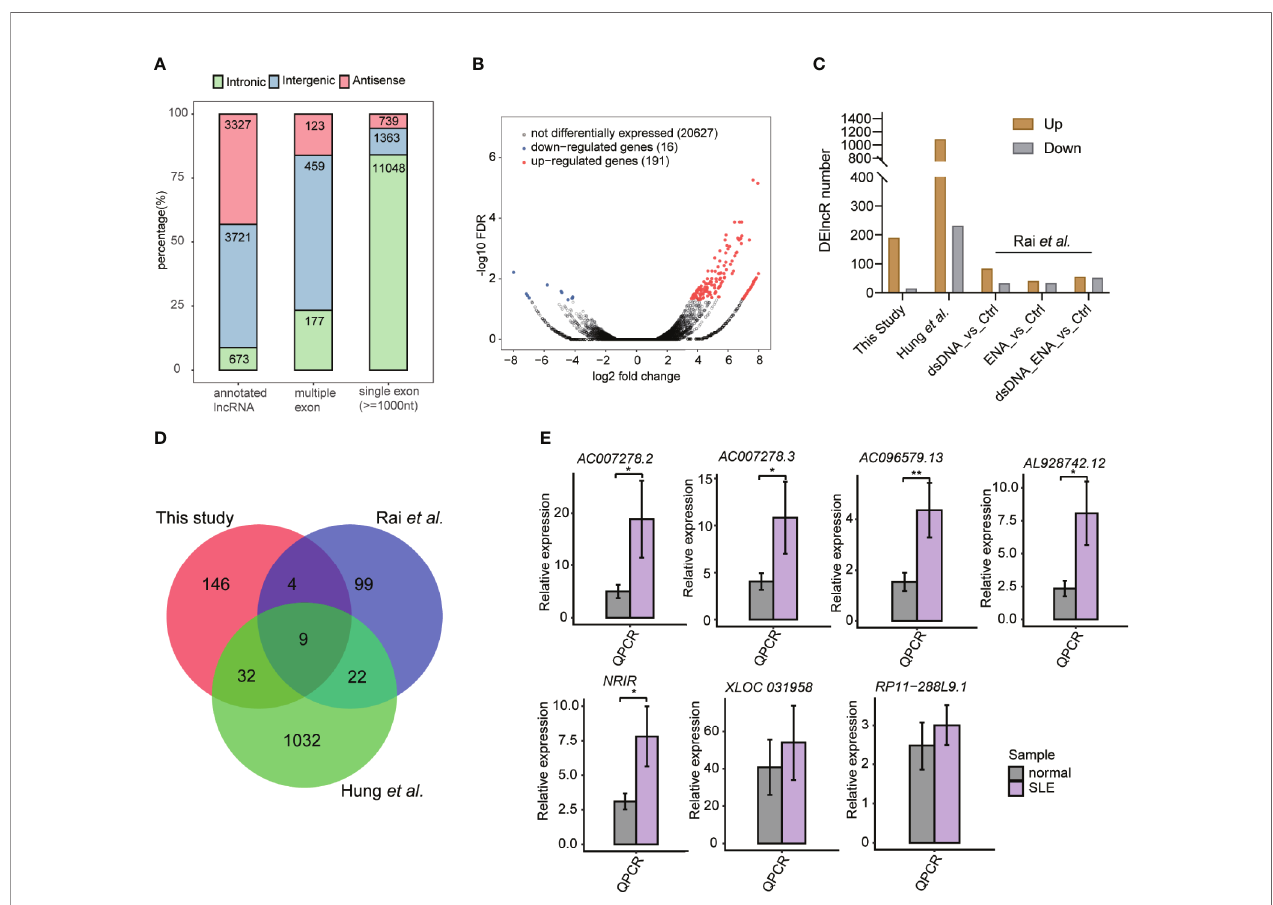
FIGURE 2 | The global and altered long non-coding RNA (lncRNA) expression pro fi le in systemic lupus erythematosus (SLE) patients and normal controls. (A) Bar plot shows the percentages of all kinds of lncRNAs in this study. (B) Volcano plot shows the dominant up-regulated lncRNAs in SLE patients, compared to the normal controls. (C) Bar plot shows the differentially expressed lncRNA (DElncR) number from the three datasets. RNA-seq samples from the study by Rai et al. were grouped into three pairs. (D) Venn diagram shows the overlapped DElncRs identi fi ed from these three RNA-seq datasets. (E) Bar plots show the RT-qPCR validation results of the seven selected DElncRs identi fi ed in this study (n = 5, mean ± standard deviation, mean ± SD). * p < 0.05; ** p < 0.01; *** p < 0.001; two-tailed unpaired t